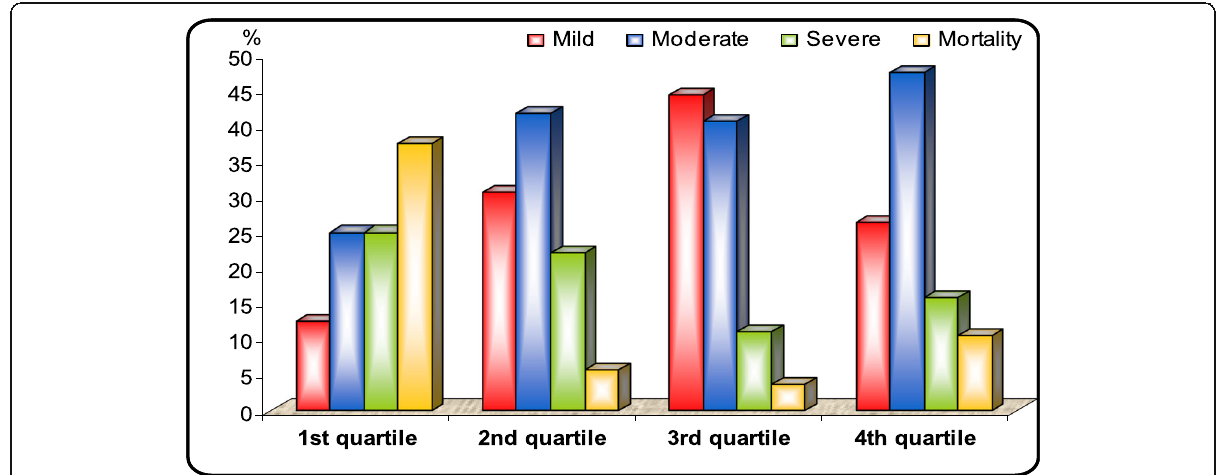
Fig. 3 Follow-up clinical severity according to stroke onset by NIHSS after 3